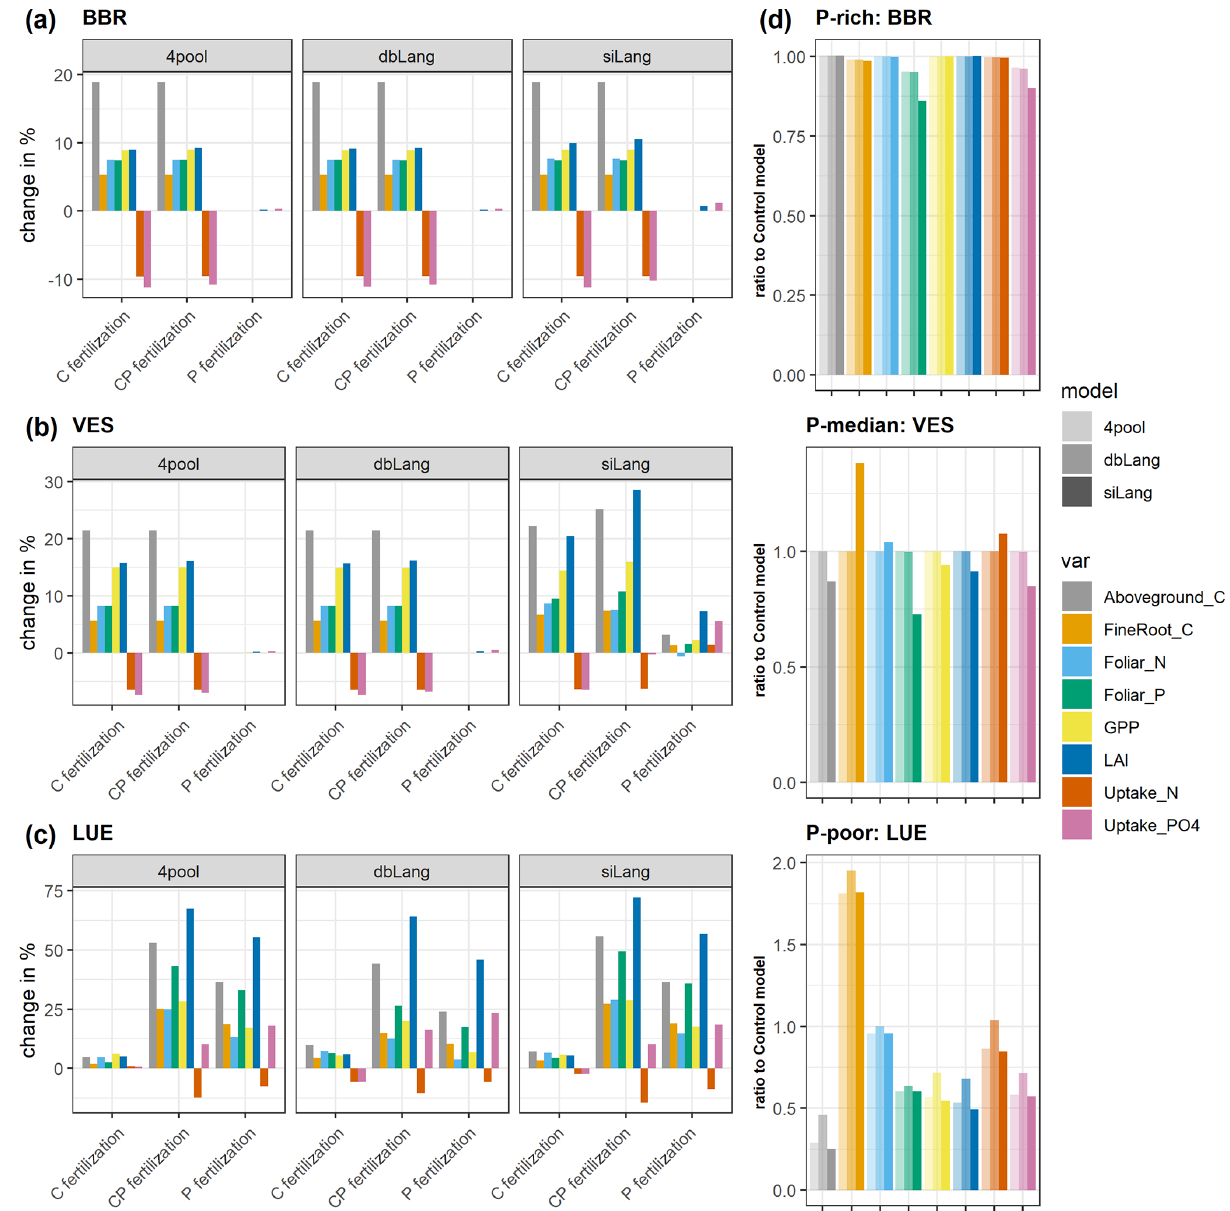
Figure 6. Simulated changes in gross primary production (GPP), aboveground C, fine-root C, leaf area index (LAI), uptake of N and P, and foliar N and P content due to CO 2 , P, and CP fertilizations at the (a) BBR, (b) VES, and (c) LUE sites, and (d) the ratio of unfertilized scenarios of each model to the Control model. Bars are calculated as the percentage change in subplots (a) to (c) , and the bars in subplot (d) are fractions representing how much the models deviate from a non-P-limited